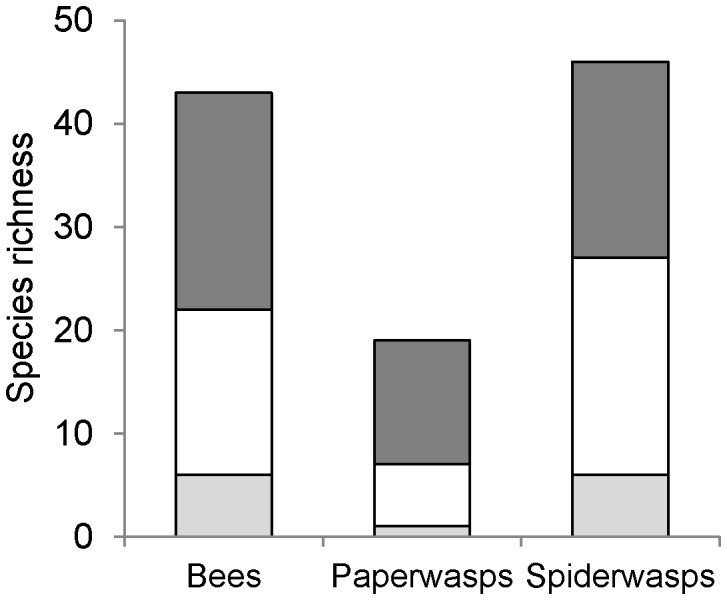
Exclusive and shared species across habitat types.Pooled species richness (over 3 months and 15 study sites) of bees, paper wasps, and spider wasps exclusively trapped in protected forest (light grey), in heterogeneous farmland (dark grey), and trapped in both habitat types (white).